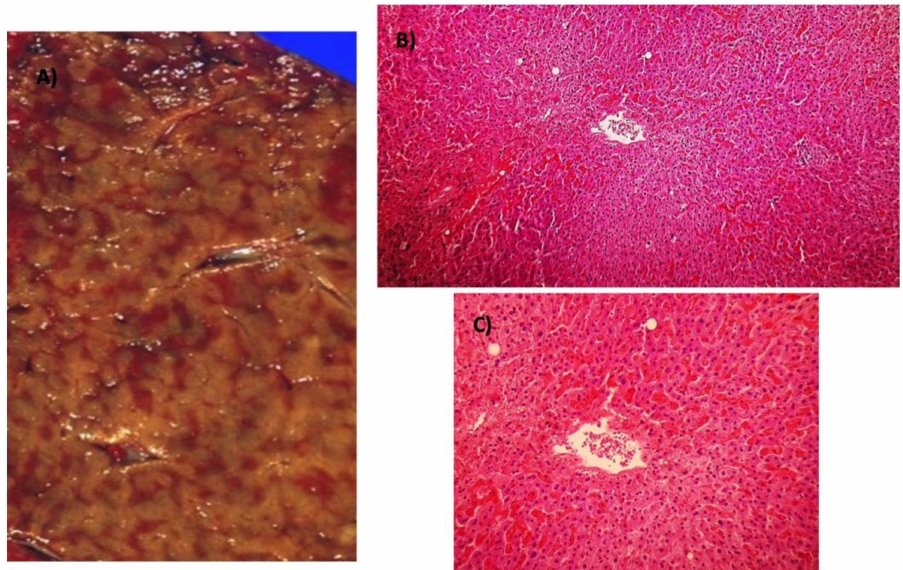
Figure 5. ( A ) Postmortem example of the classical “nutmeg” liver with centrilobular congestion in congestive hepatopathy (CH). ( B ) Centrilobular regions show congestion and extravasation of red